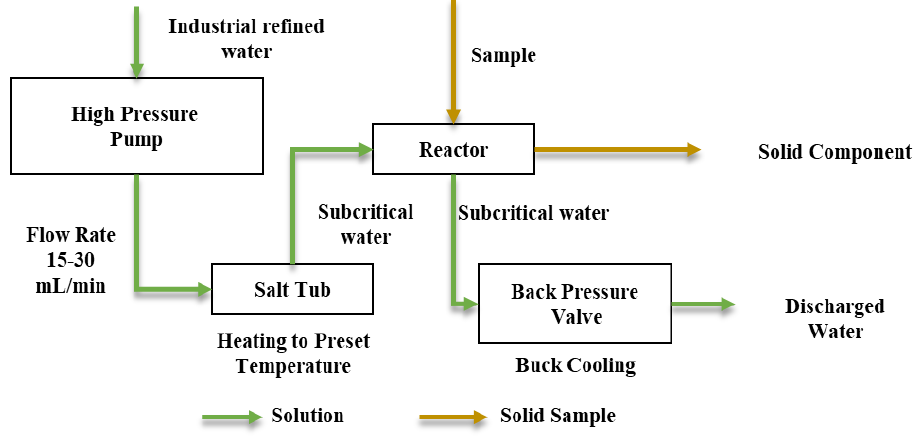
Figure 5. Floor plan of the liquid flow reactor.